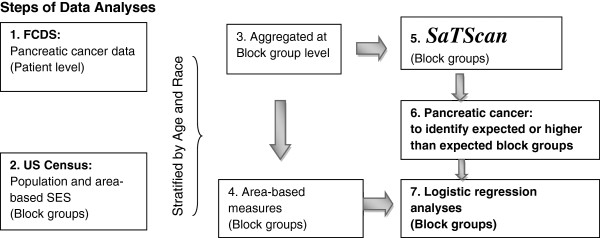
Steps of Data Analyses.